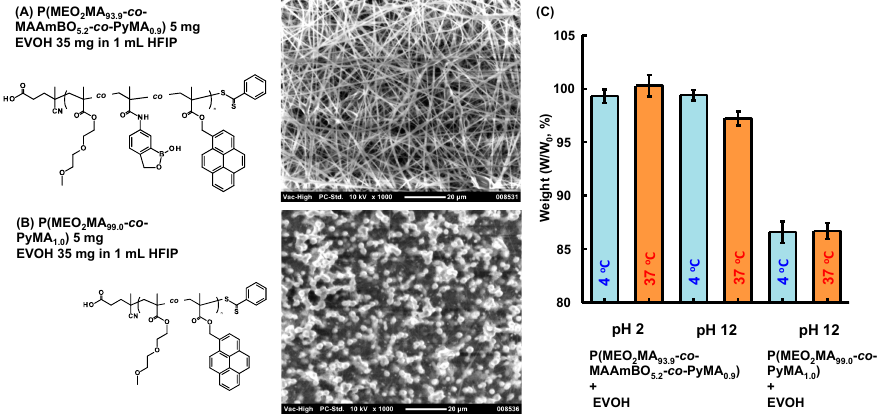
Figure 5. SEM images of electro-spinning samples: ( A ) P(MEO 2 MA 93.9 - co -MAAmBO 5.2 - co -PyMA 0.9 ) (5 mg) and EVOH (35 mg); and ( B ) P(MEO 2 MA 99.0 - co -PyMA 1.0 ) and EVOH (35 mg) in 1 mL HFIP. ( C ) Weight loss ((weight after immersion test, W )/(weight before immersion test, W 0 ) × 100 %) at various immersion conditions for 24 h.